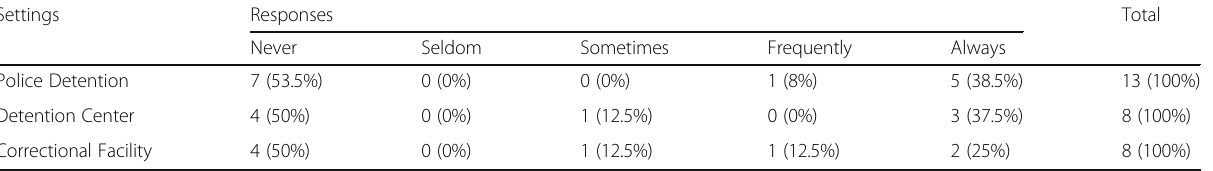
Table 4 Paralegals ensure clients have access to medicine Settings